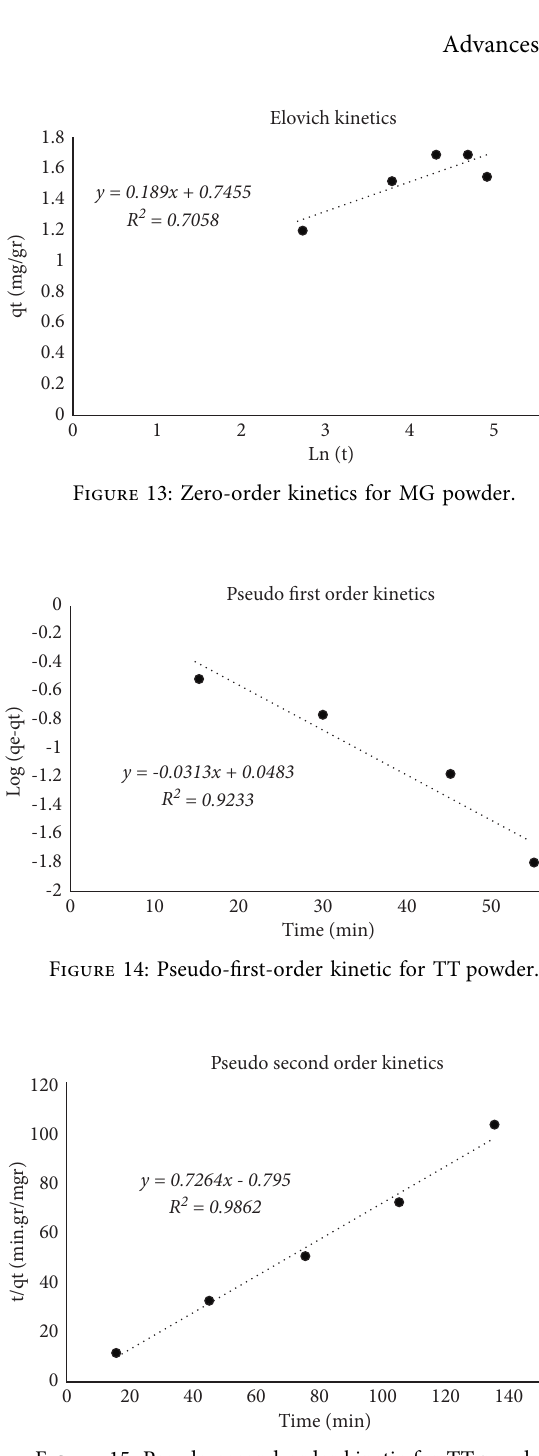
Figure 15: Pseudo-second-order kinetic for TT powder.